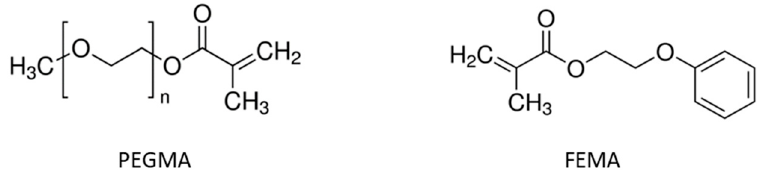
Figure 9. The monomethacrylates used in the study; PEGMA has an average molecular weight of 300 g/mol.